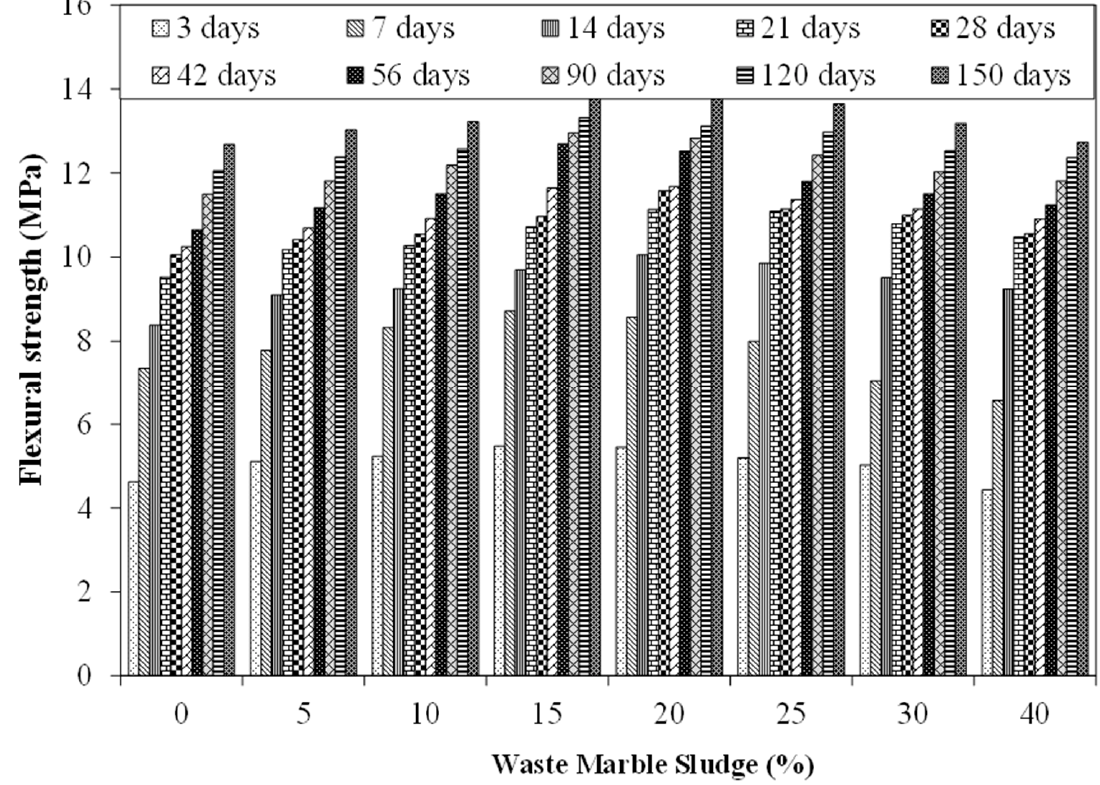
Figure 5. Flexural strength results.